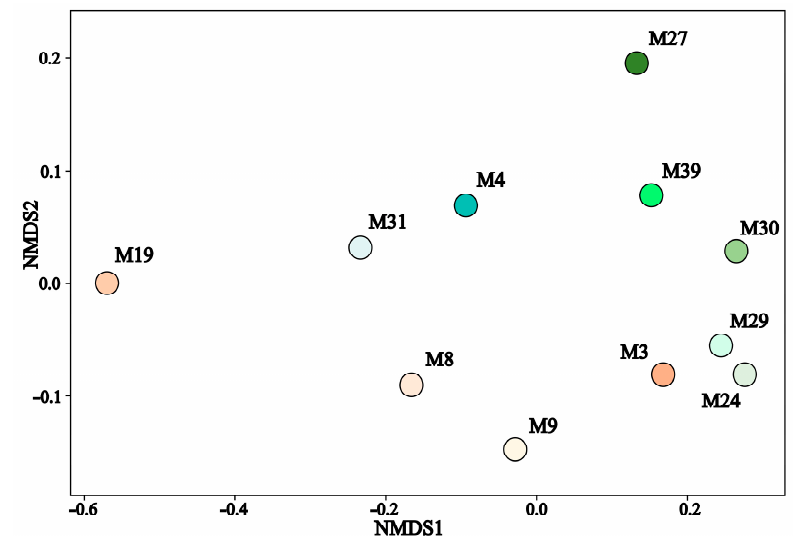
Figure 5. Non-metric multidimensional scaling (NMDS) plot based on the Bray–Curtis similarity coefficients of experimental soil samples. Points closer to one another in ordination space are more similar than those apart.